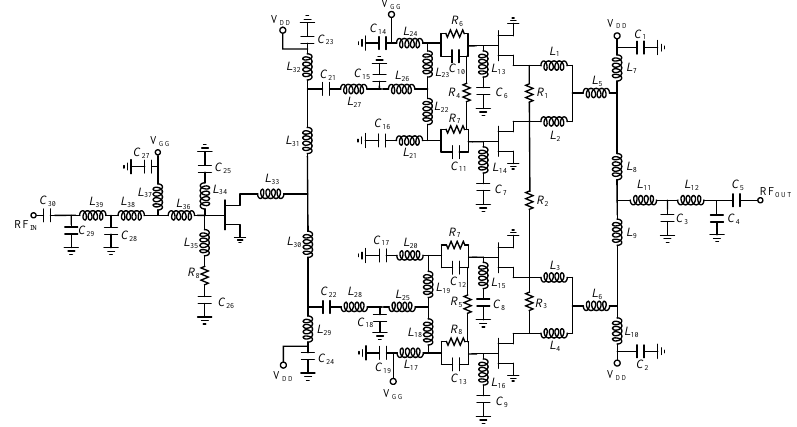
Figure 4. The schematic of the presented high-efficiency power amplifier.